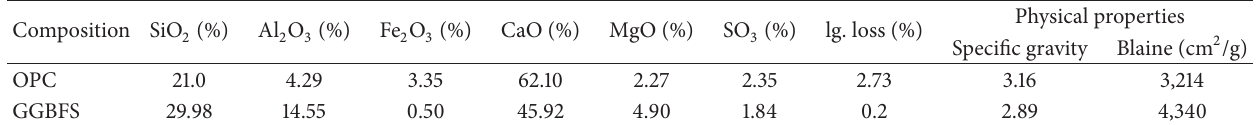
Table 3: Chemical compositions of OPC and GGBFS.